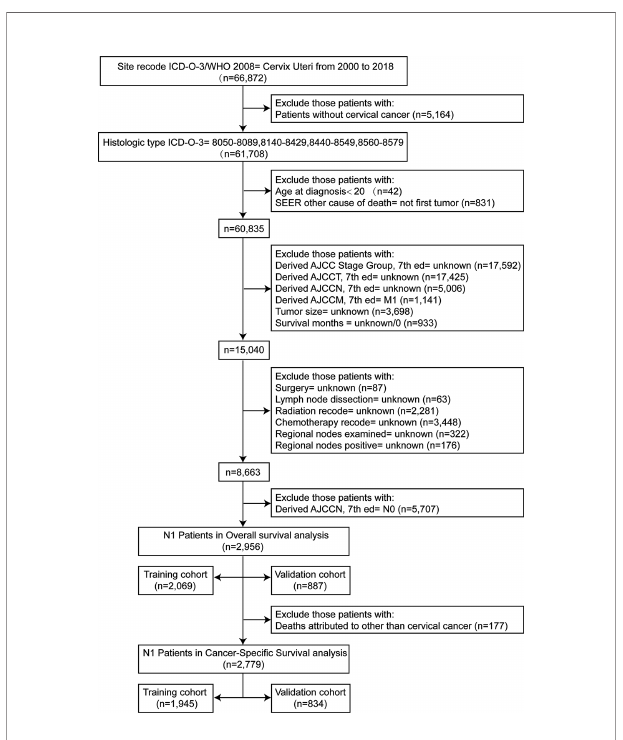
FIGURE 1 | The fl ow chart of the patient ’ s selection